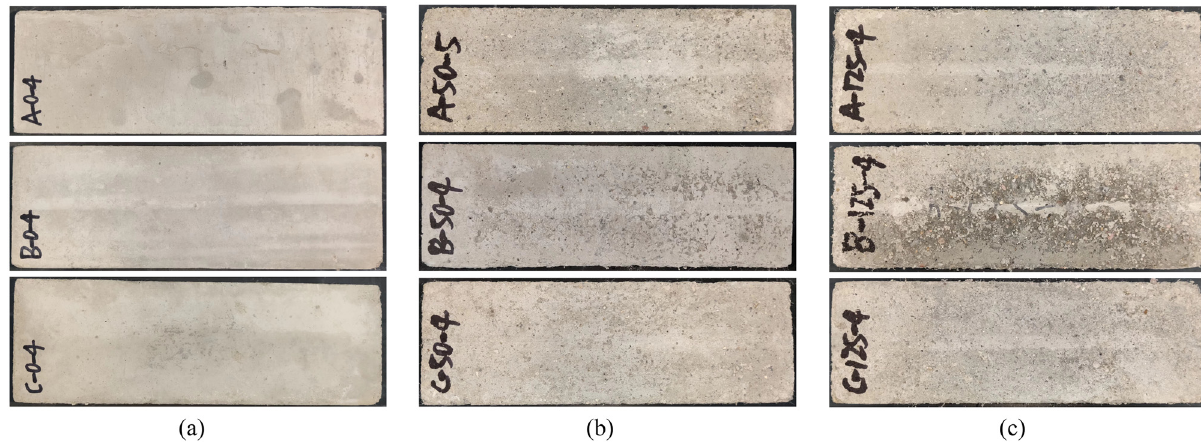
Figure 7: Appearance characteristics of concrete before and after freezing and thawing: ( a ) 0 time, ( b ) 50 time, and ( c ) 125